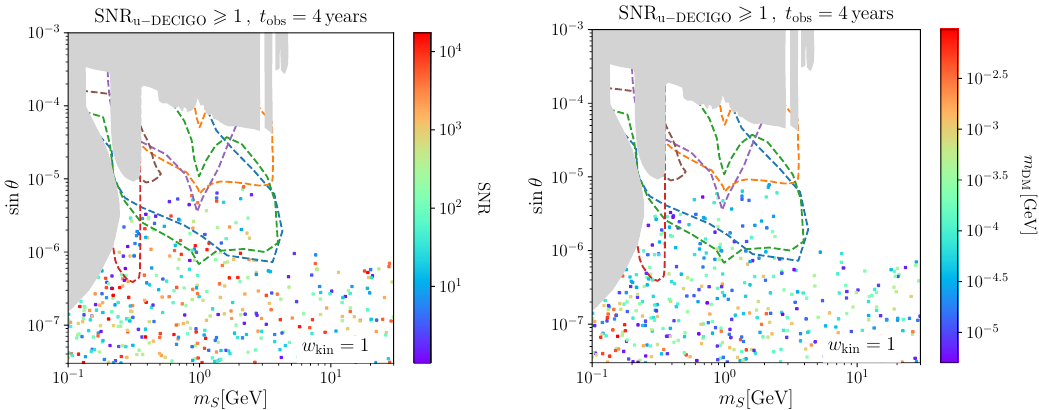
Figure 5 . Comparison between the points in parameter space which will detected by u- DECIGO after 4 years of exposure (with SNR > 1 ) and the sensitivity limits which will be probed in future long-lived particle searches. The dashed contours depict such regions for FASER II (orange) [169–172], DUNE (red) [173, 174], DarkQuest-Phase 2 (purple) [175], MATHSULA (green) [176], PS191 (brown) [177, 178], and SHIP (blue) [179]. We considered the case w kin = 1 in both plots and the color bar indicates the values of the DM mass in the left panel, and the value of the expected SNR in the right panel. 3